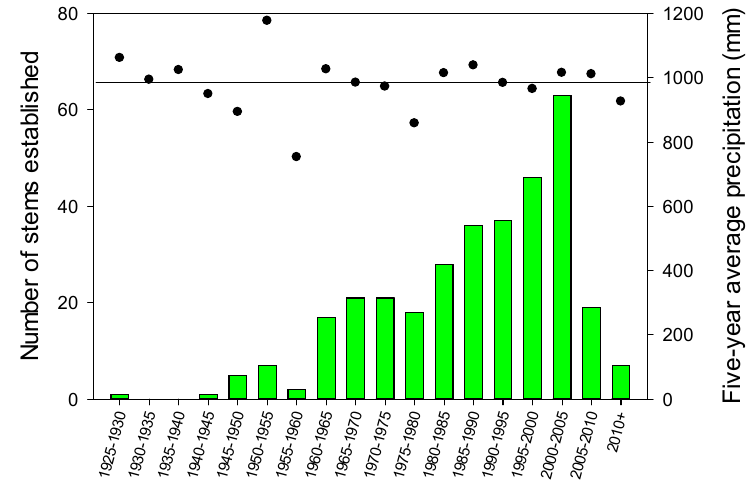
Figure 5. All Juniperus virginiana stems by bi-decadal age class with 5-year precipitation average. Data were based on stem disks at ground level or from cores at breast height that were corrected to year of establishment. Young J. virginiana with establishment dates after 2007 are not expected to have reached breast height and were not included in the sampling.